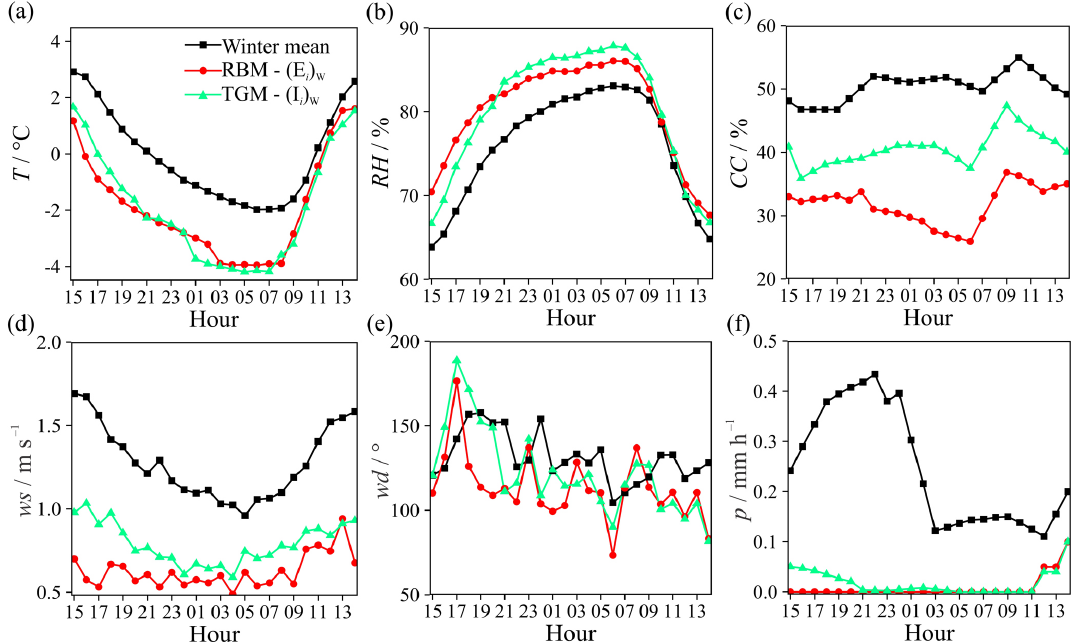
Figure 12. Diurnal composites, based on hourly means, of (a) air temperature, (b) relative humidity, (c) cloud cover, (d) wind speed, (e) wind direction, and (f) precipitation, for winter mean, and persistent temperature inversion events detected in winter by the RBM and TGM. 2–3.2 m s − 1 (not shown). Between 00:00 and 05:00 LT